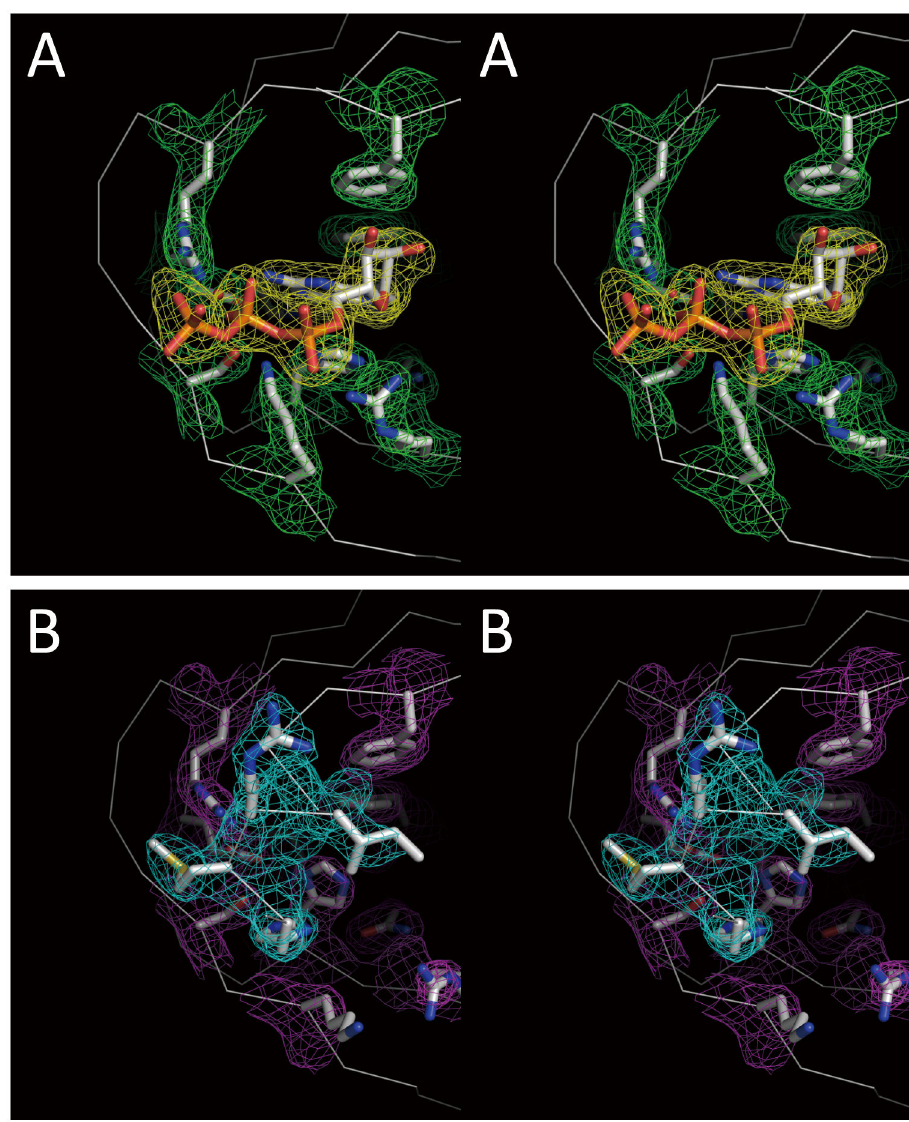
Figure 2. Electron densities of the active sites in stereo view. The molecular orientation is the same as bottom view in Figure 1. The 2Fo-Fc electron density maps are drawn at one sigma. A) The active site of m 7 GTP-bound form. The electron density of m 7 GTP and the active site residues are represented in yellow mesh and green mesh, respectively. 6B) The active site without m 7 GTP. The electron density of additional N-terminal helix and the active site residues are represented in cyan mesh and magenta mesh,